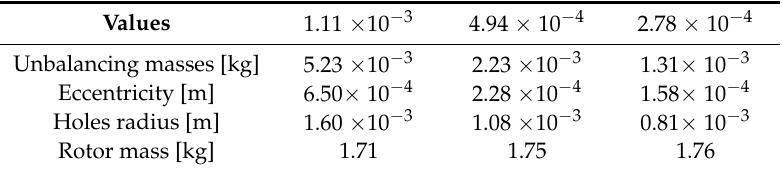
Table 8. Mass and eccentricity values for each rotor speed.